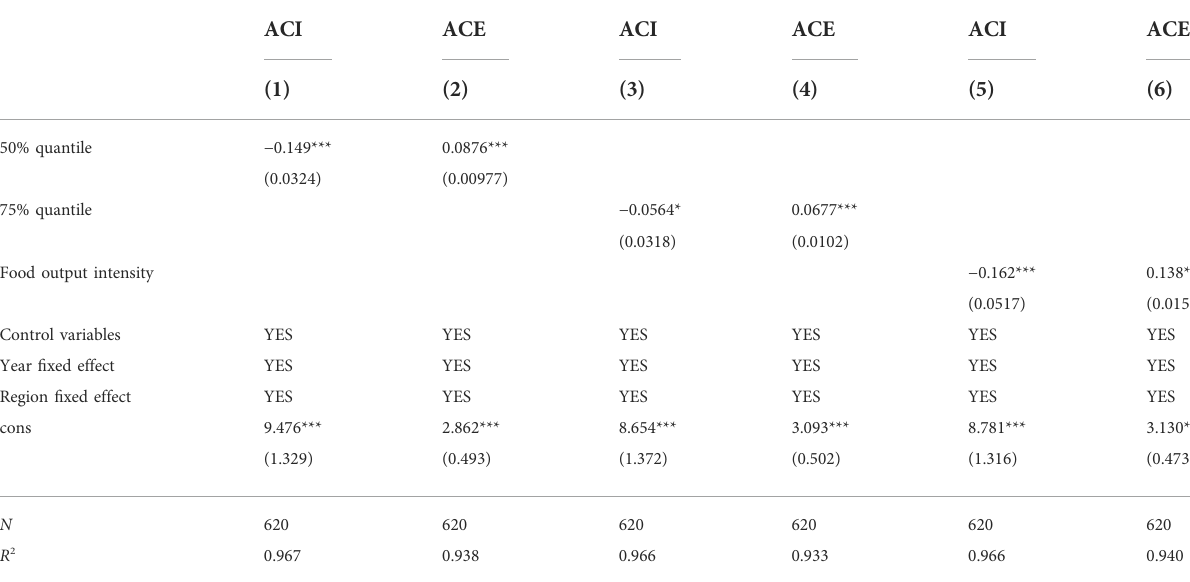
TABLE 4 Robustness tests